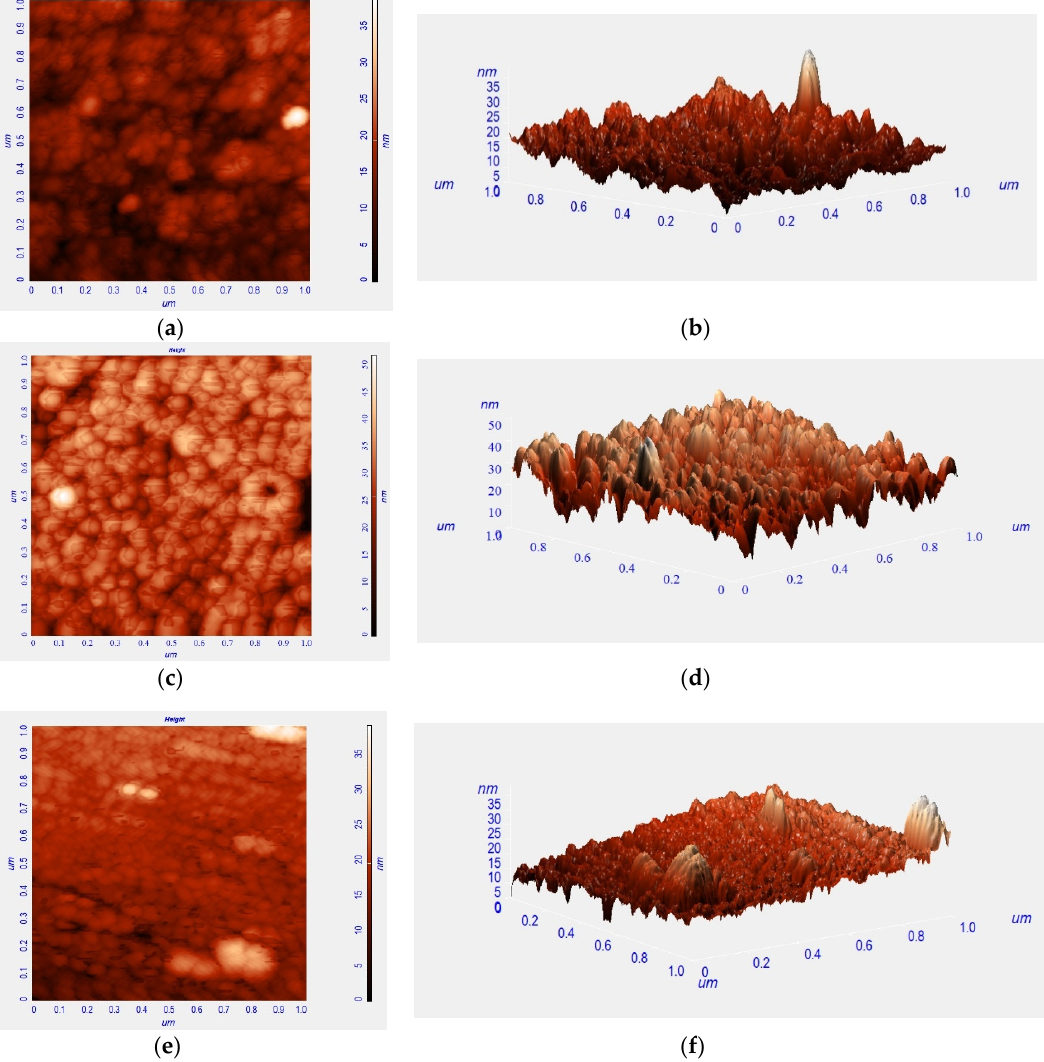
Figure 3. AFM images of a TIECP-coated electrode ( a , b ) before, ( c , d ) after template removal and ( e , f ) rebinding of the target molecules. ( left ) Height shown as intensity; ( right ) 3D representation (height exaggerated relative to horizontal scale.).